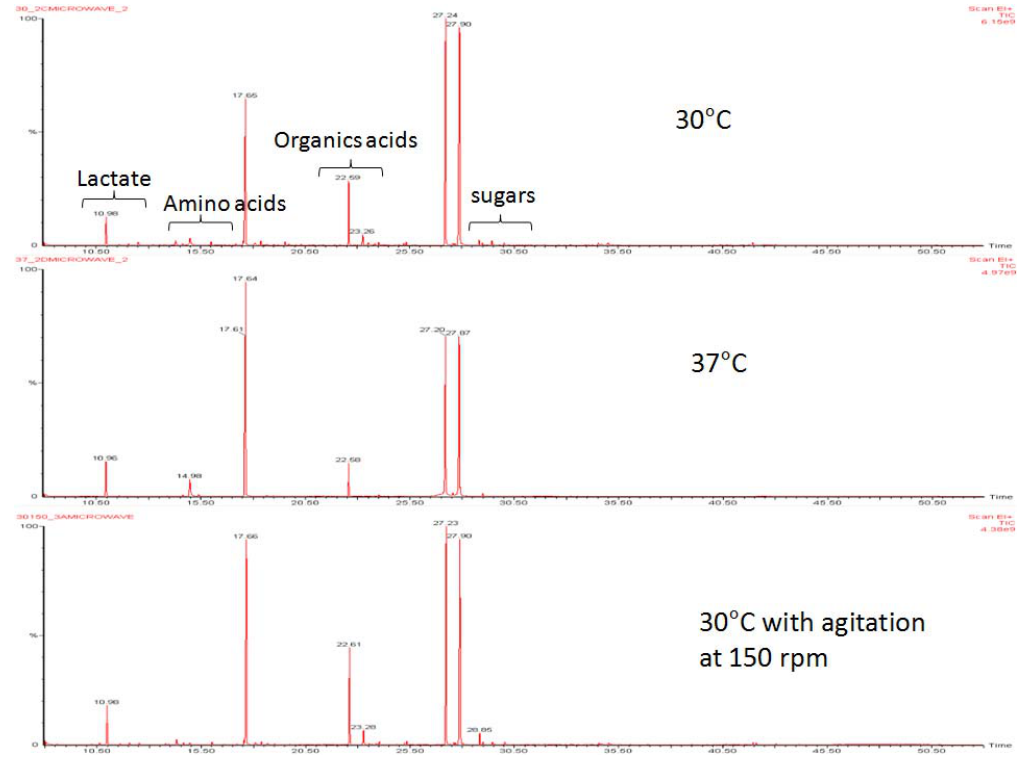
Figure 1. Metabolic profiles of L. lactis under growth conditions without agitation at 30 °C, and 37 °C, and 30 °C with agitation. Profiles were obtained using TMS derivatization and measured by GC-MS.